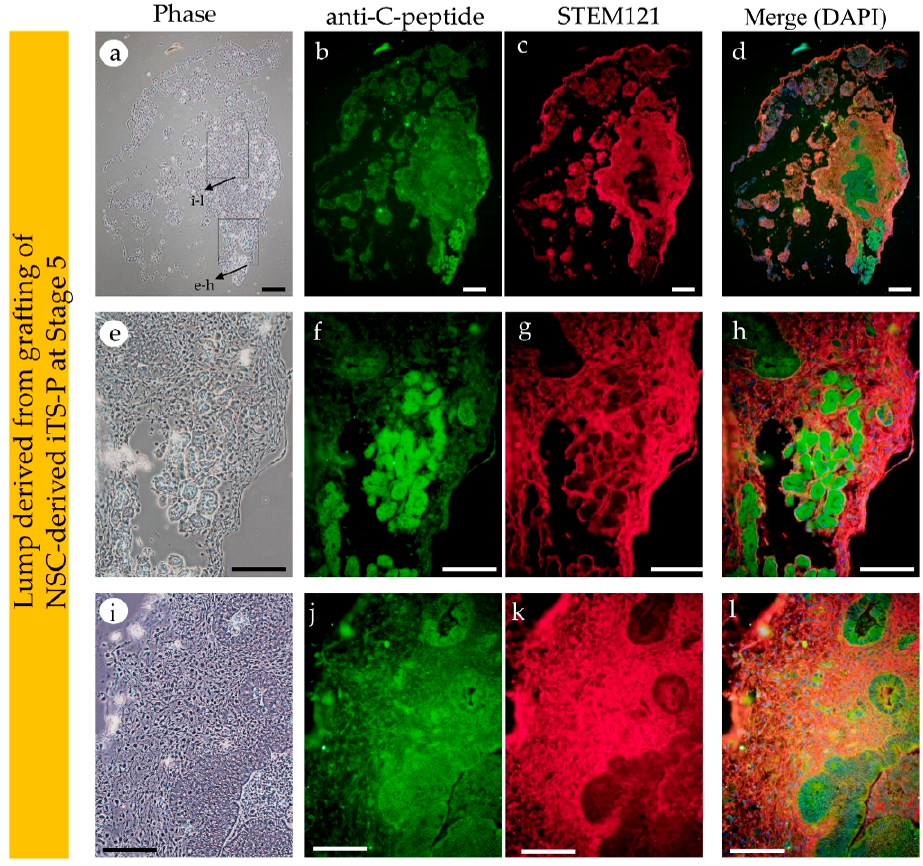
Figure 6. Immunohistochemical staining of cryostat sections stained with anti-C-peptide (Green) and STEM121 (Red). The lump grown in the pancreas of nude mouse after staining with anti-C-peptide antibody, and subsequently with human cells-specific monoclonal antibody STEM121. Magnified images in ( e – h ) and ( i – l ) are derived from boxes shown in ( a ). The portion shown in ( a – d ) corresponds to that shown in B(a-d) of Figure 5. Similarly, the portion shown in ( e – h ) corresponds to that shown in Figure 5B(e–h), and the portion shown in ( i – l ) corresponds to that shown in Figure 5B(i–l). Notably, the portion stained with anti-insulin antibody was also highly stained by anti-C-peptide antibody. Bar = 100 µm.